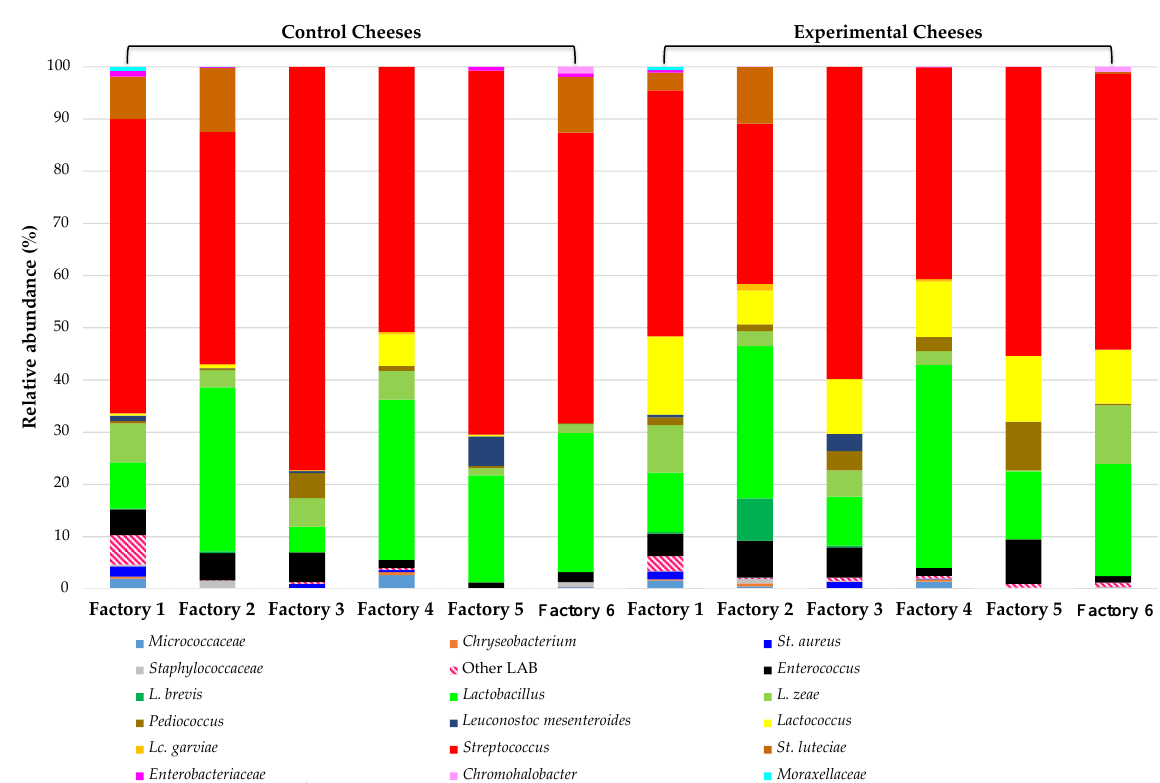
Figure 9. Relative abundances (%) of bacteria identified by MiSeq Illumina in control and experimental PDO Pecorino Siciliano cheeses. Adapted from Gaglio et al. [70] .